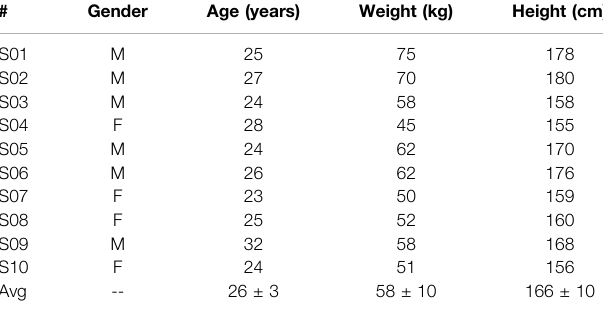
TABLE 1 | Details of study